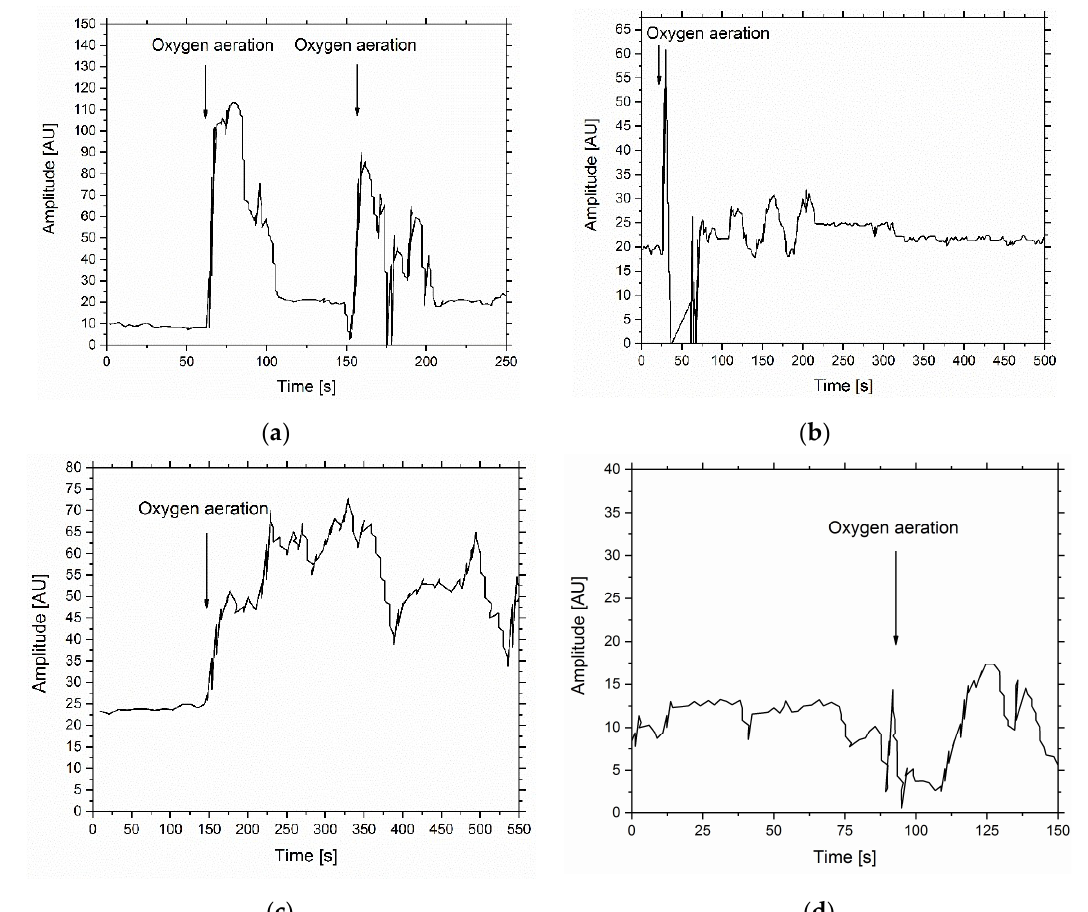
Figure A9. A 1% ( w / v ) agarose gel including the bacterial cells was casted with a final cell density of